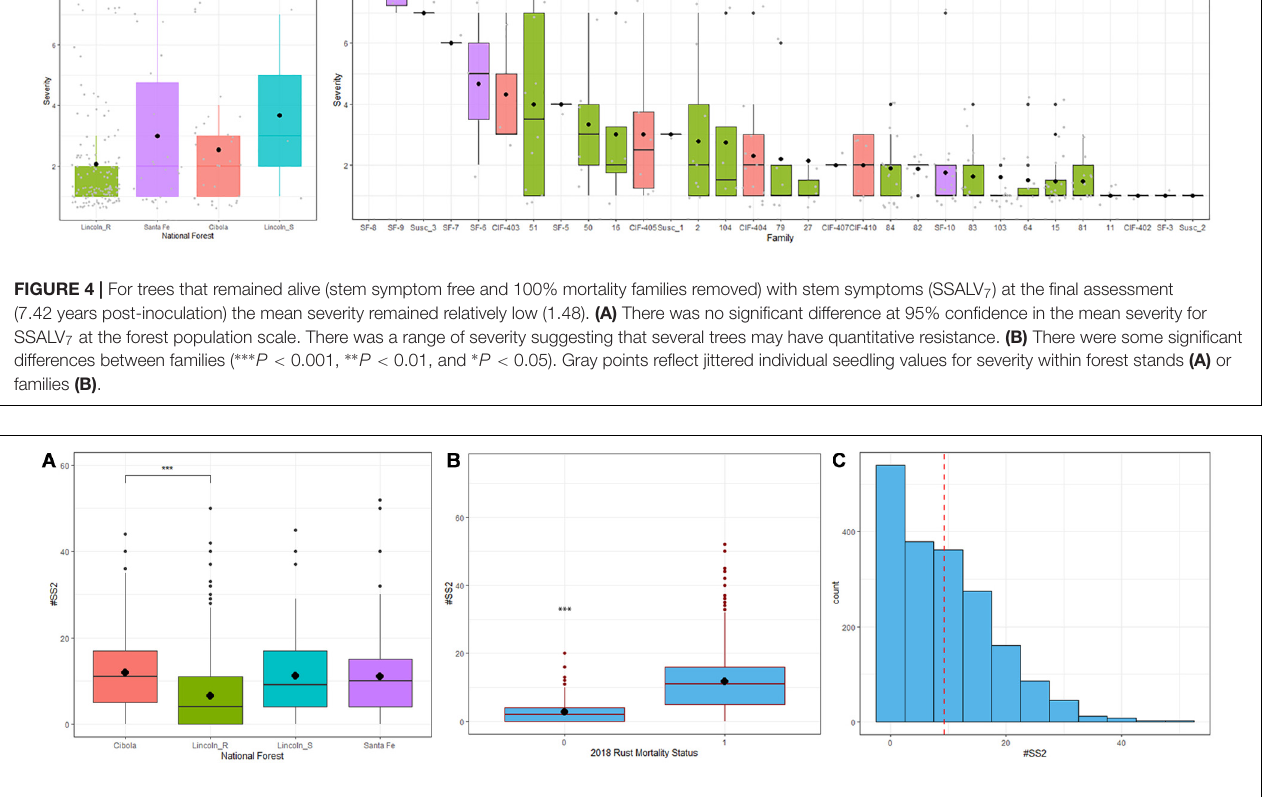
FIGURE 5 | (A) Lincoln R (green) had significantly fewer ( P < 0.01) stem symptoms than the Cibola (pink), Santa Fe (purple) and Lincoln S (blue) National Forests. ∗∗∗ P < 0.01 (B) The difference in mean number of stem symptoms at 2nd assessment (1.42 years post-inoculation) between trees that remained alive with stem symptoms (SSALV 7 ) at final assessment and those that died of rust. SSALV 7 trees had significantly fewer stem symptoms than their counterparts that died of rust ( P < 0.01). (C) The frequency distribution of all stem symptoms (normal cankers + complete bark reactions + partial bark reactions) at 2nd assessment had a mean number of stem symptoms of